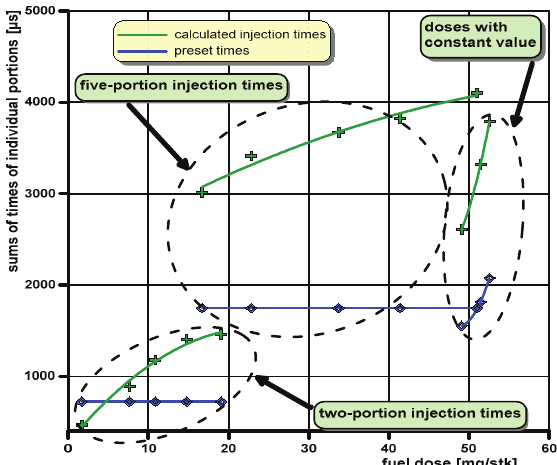
Fig. 7. Collation of sums of times of individual portions of the dose for the analyzed measuring cases